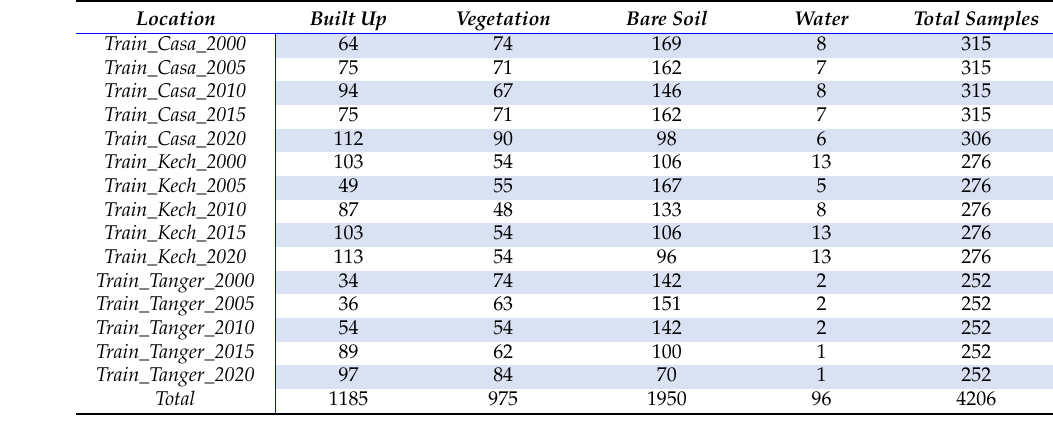
Table A1. Statistics of samples used in the